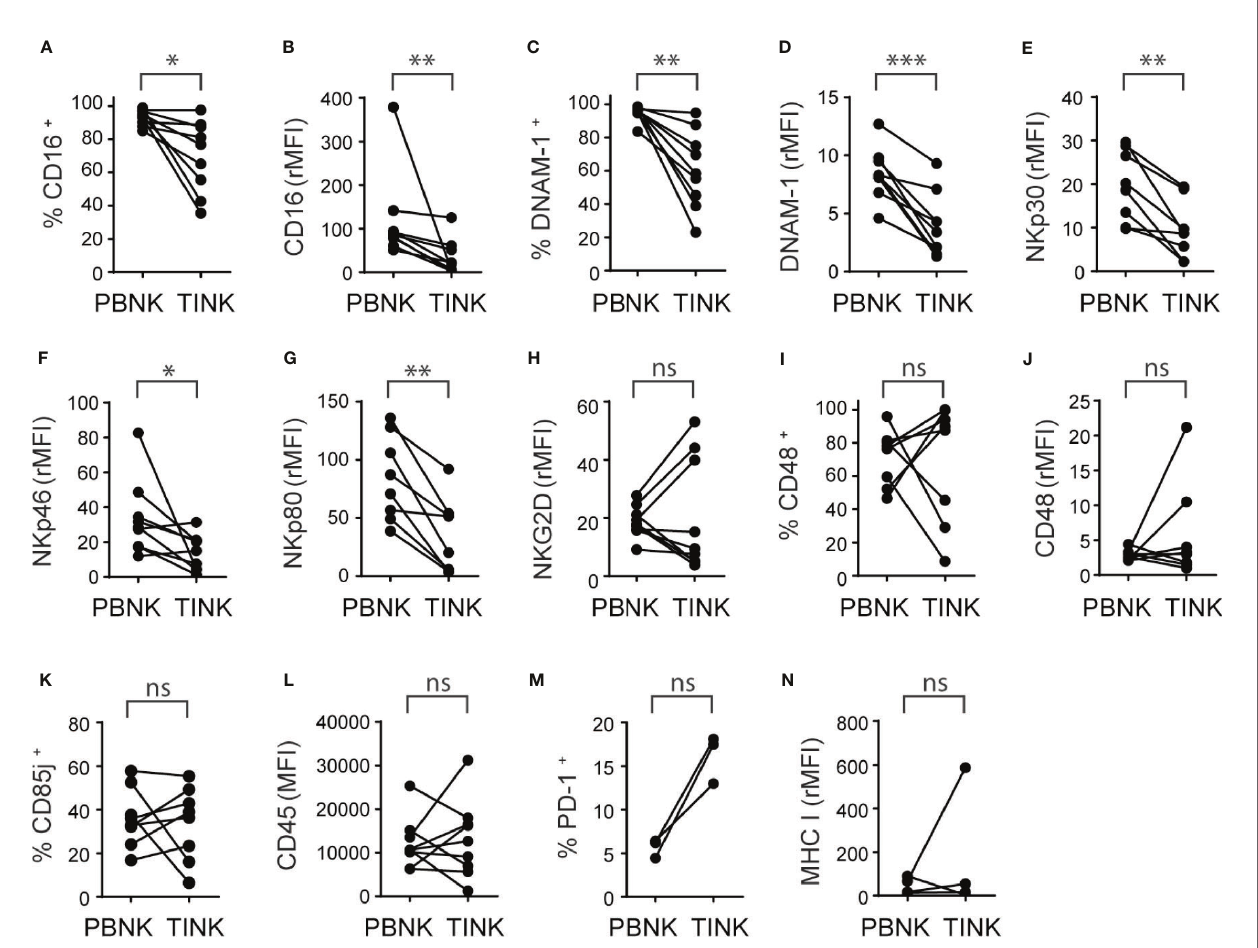
FIGURE 4 | TINK from ccRCC patients exhibit a similar increased expression of inhibitory receptors than PBNK and additional decreased expression of activating receptors. Peripheral blood NK cells (PBNK) and tumor-in fi ltrating NK cells (TINK) from ccRCC patients were analyzed by FC to compare the frequency of CD16 + cells (A) , the intensity of expression of CD16 (B) , the frequency of DNAM-1 + cells (C) , the intensity of expression of DNAM-1 (D) , the intensities of expression of NKp30 (E) , NKp46 (F) , NKp80 (G) and NKG2D (H) , the frequency of CD48 + cells (I) , the intensity of expression of CD48 (J) , the frequency of CD85j + cells (K) , the intensity of expression of CD45 (L) , the frequency of PD-1 + cells (M) and the intensity of expression of MHC-I (N) . In (B, D – H, J, N ), the relative MFI (rMFI) was used instead of MFI because the FMO was different for PBNK and TINK. n =9 (A – D , F, H, L) ; n =8 (E, G, I – K) ; n =3 (M) ; n =4 (N) . A two-sided paired t-test was used in (A, D, E, G – I) and (K) A two-sided paired t-test with Wilcoxon rank test was used in (B, C, F, J, L, N) . ns, not signi fi cant; * p < 0.05; ** p < 0.01; *** p <